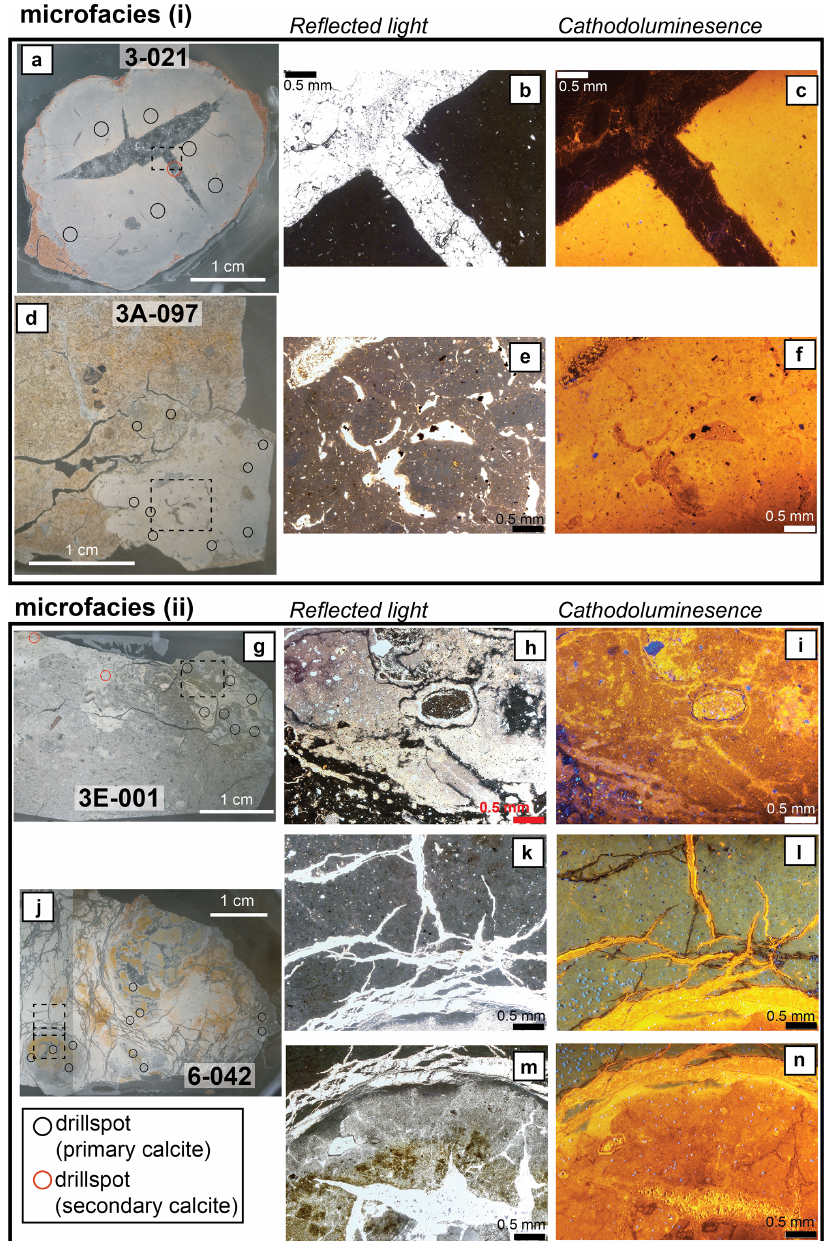
Figure 3. Reflected light (left column), transmitted light (middle column) and cathodoluminescence (CL; right column) images of select nodule thin sections (two from each microfacies group; top two samples are microfacies (i) and bottom two samples are microfacies (ii)). Samples 3-021 (a–c) , 3A-097 (d–f) , 3E-001 (g–i) and 6-042 (j–m) are included. Drill spots for δ 13 C and δ 18 O analysis, mapped from billets, are indicated by circles. Dashed squares are the approximate field of view for transmitted light and CL